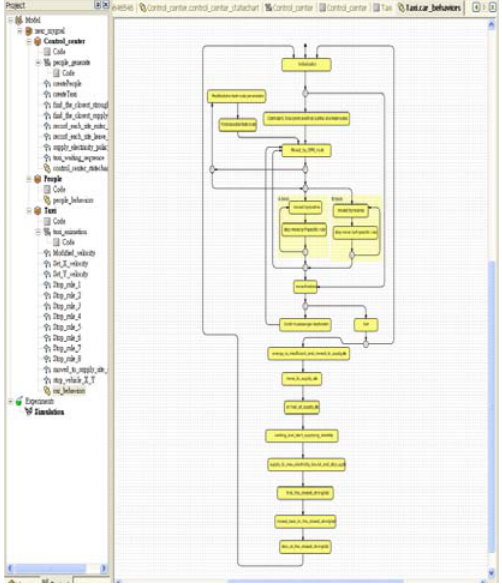
Figure 13(b). “The agent state of electric-taxi DAR operation system”.